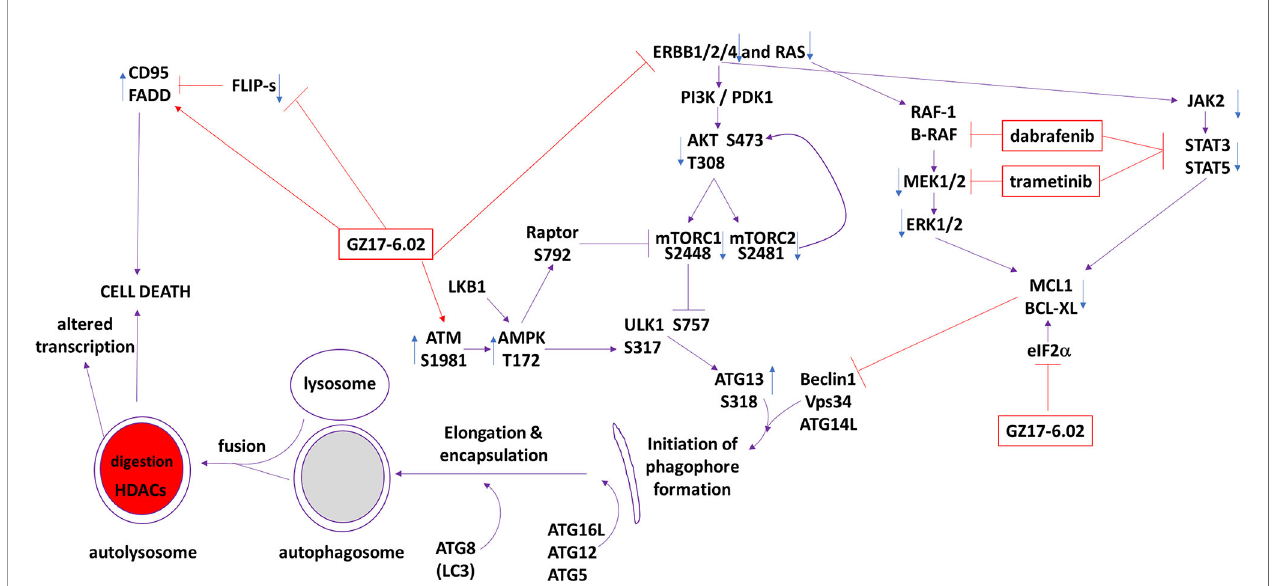
FIGURE 12 | The molecular mechanisms by which GZ17-6.02 interacts with [trametinib + dabrafenib] to kill cutaneous melanoma cells that express B-RAF V600E. In MEL2 and MEL4 cells GZ17-6.02 initially interacted after a 4h exposure with [trametinib + dabrafenib] to cause inactivation of STAT3, p70 S6K and ERK1/2. In MEL4 cells they also combined to inactivate JAK2, STAT5, eIF2 a , NF k B and reduced HSP70 levels. In MEL2 cells they also combined to inactivate c-SRC. Eight h after exposure the drugs interacted to maintain phosphorylation of the AMPK and eIF2 a , and to decrease the phosphorylation of MEK1/2 and STAT3. The levels of CD95 in both isolates remained elevated at the 8h time-point. Molecular studies demonstrated that cells lacking ATM-AMPK signaling, lacking the ability to form autophagosomes or activate CD95 death receptor signaling were less able to undergo cell death processes. Over-expression of BCL-XL or dominant negative caspase 9, expression of activated STAT3 or knock down of eIF2 a was more effective at suppressing cell killing than over-expression of FLIP-s or activated forms of mTOR, AKT or